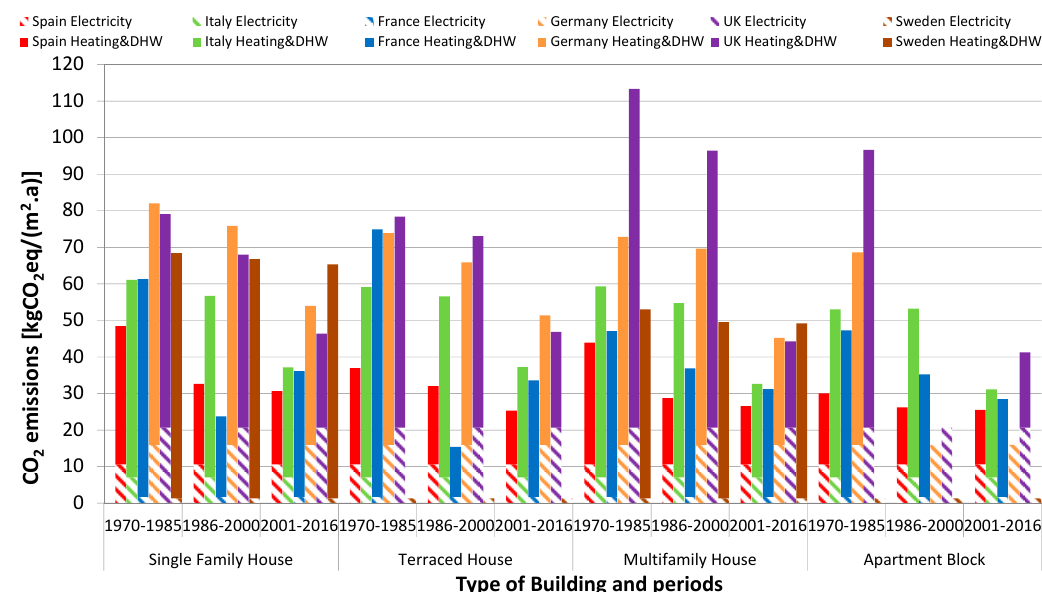
Figure11. CO 2 emissionsofelectricity, Figure 11. CO 2 emissions of electricity, heating and DHW consumption per square metre in cold climates.